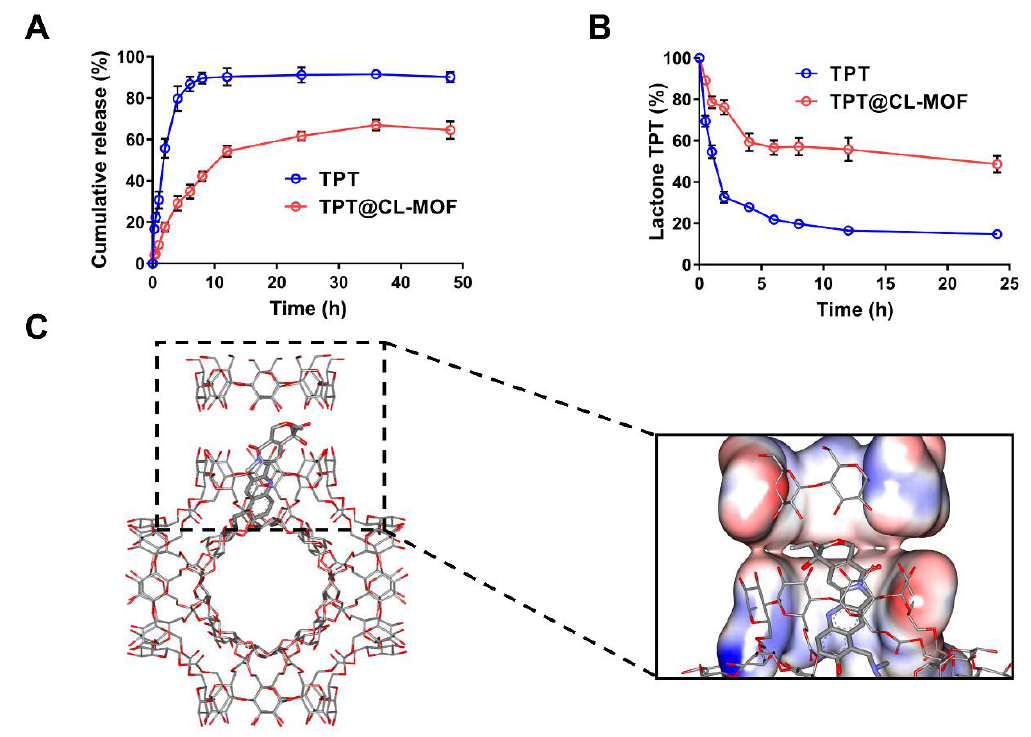
Figure 2. CL- MOF was effective as a drug carrier for TPT’s slow release and stability protection. Cumulative release profiles of TPT ( A ) and the protection effect of TPT@CL-MOF ( B ) in the Buffers with pH 7.4 ( n = 3). Conformation of TPT molecule (rod model) distributed in CL-MOF ( C